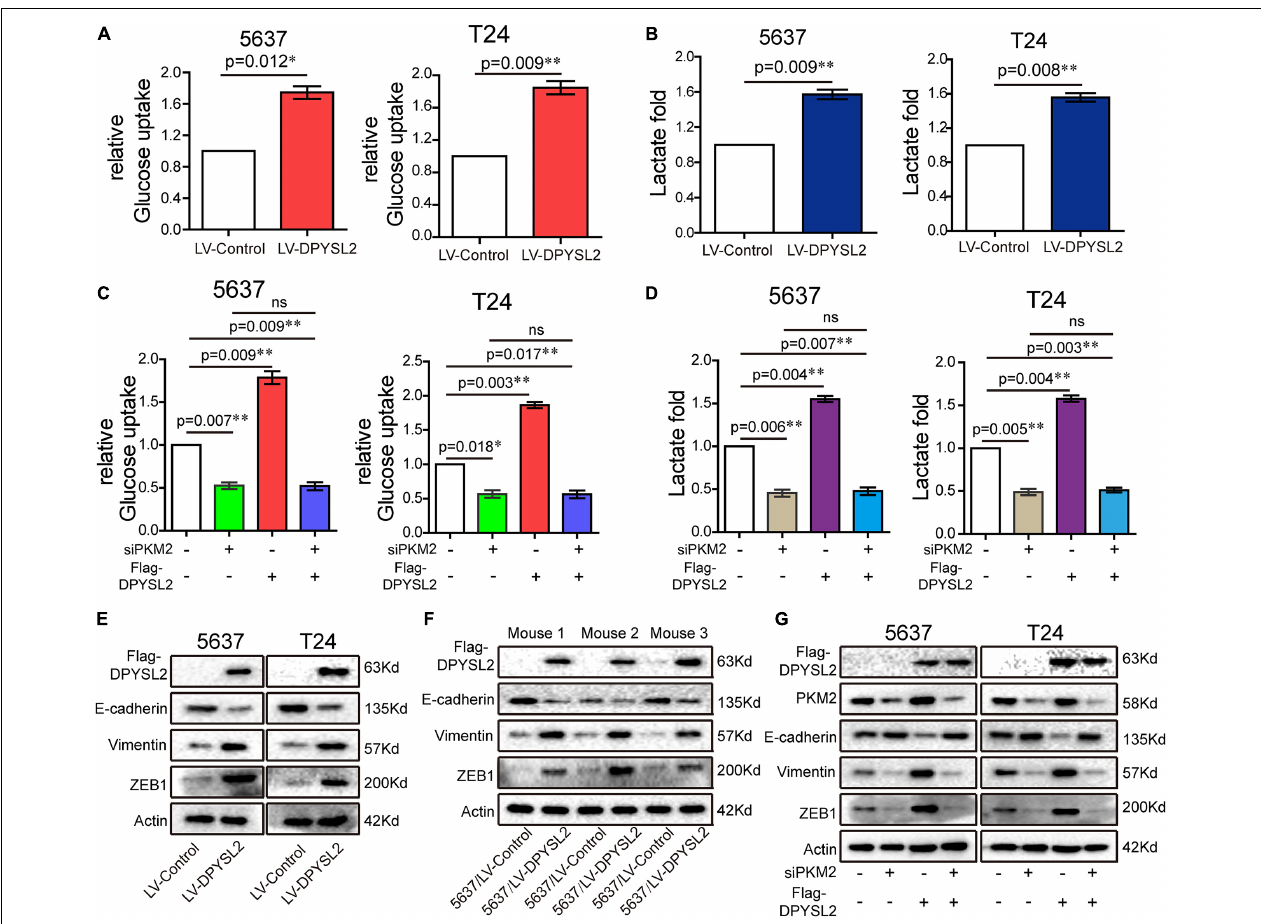
FIGURE 6 | Dihydropyrimidinase like 2 (DPYSL2) promoted aerobic glycolysis and epithelial–mesenchymal transition (EMT) via PKM2. (A,B) Glucose uptake (A) and lactate production (B) were measured in 5637 and T24 cell lines stably overexpressing DPYSL2. (C,D) 5637 or T24 cells were transfected with Flag-DPYSL2 plasmids and siPKM2 individually or in combination. Glucose uptake (C) and lactate production (D) were measured, respectively, at 36 or 48 h after transfection. (E,F) Western blot analysis was performed to determine EMT marker expression in 5637 and T24 cell lines stably overexpressing DPYSL2 (E) and in three pairs of mouse tumors (F) . (G) 5637 or T24 cells Flag-DPYSL2 plasmids and siPKM2 individually or in combination. Western blot analysis was performed to measure EMT marker expression. Actin was used as an internal reference. Data are expressed as the mean ± SEM. * P < 0.05, ** P < 0.01; ns, non-significant; n =